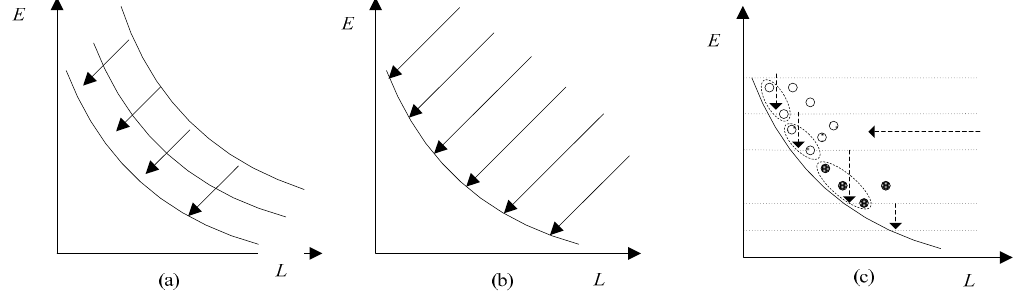
Figure 1. The search schemas in methods ( a ) Pareto-based; ( b ) Decomposition via aggregation; ( c ) UACS.